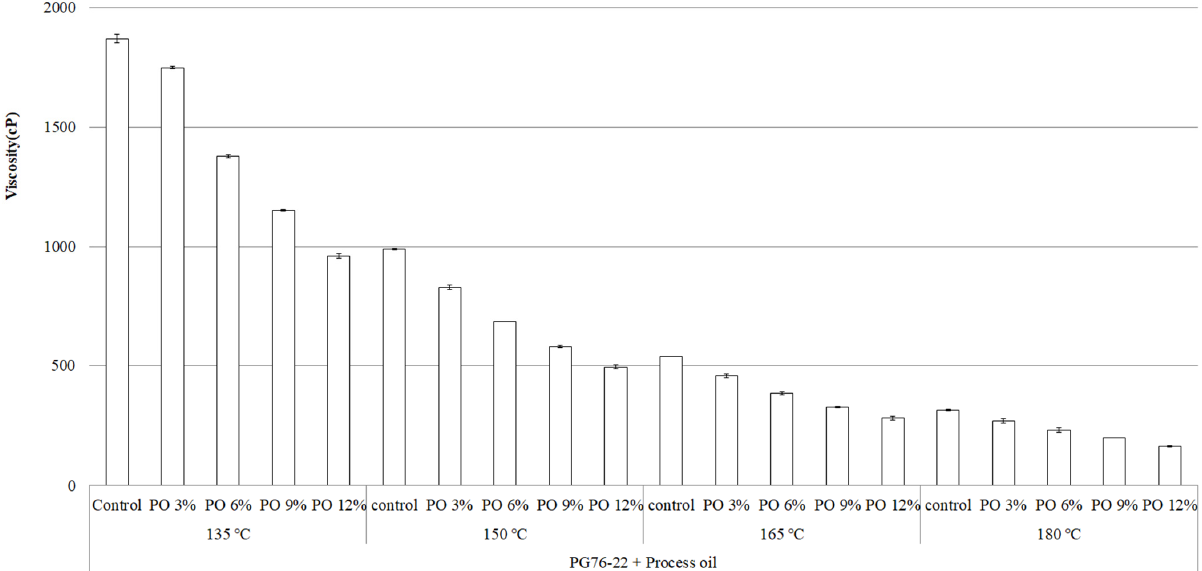
Figure 3. Viscosity of PG 64-22 binder as a function of processed oil content and temperature increment.